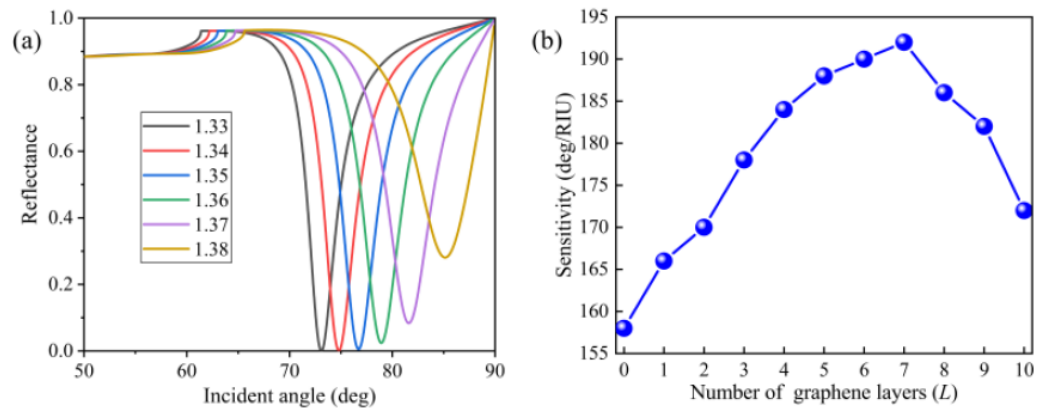
Figure 7. ( a ) Variation of reflectance with respect to the incident angle of the proposed sensor with monolayer graphene. The refractive index of sensing medium changed from 1.33 to 1.38. ( b ) Variation of sensitivity with respect to different number of graphene layers ( L ) when the refractive index of sensing medium was 1.33 + ∆ n .